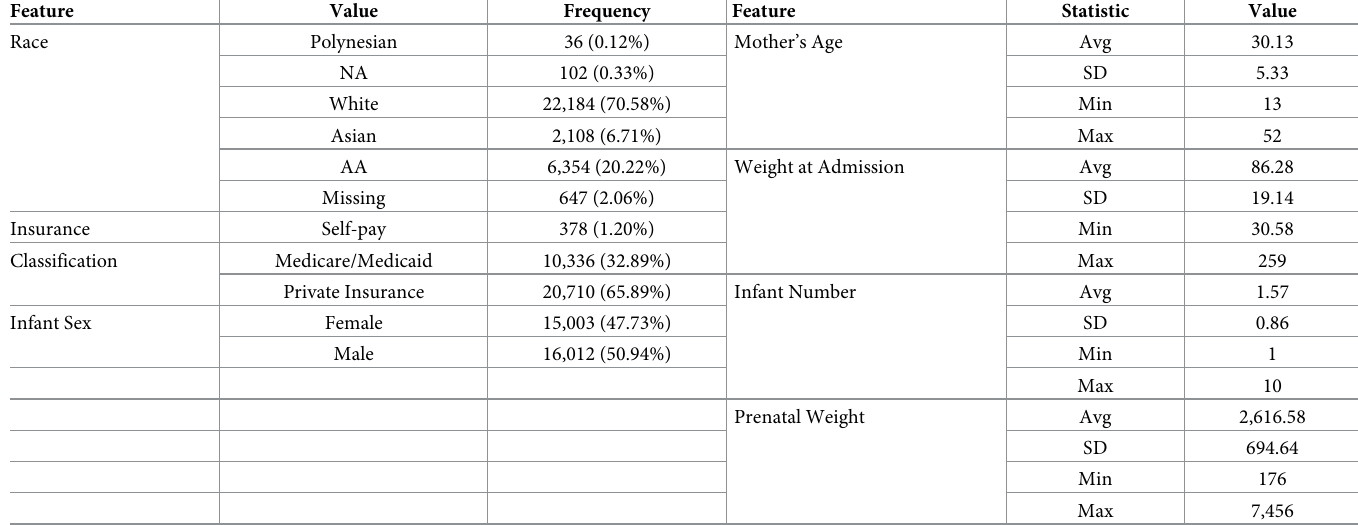
Table 9. Patient demographic attributes in the MOMI data. We report the average (Avg), standard deviation (SD), minimum (Min), and maximum (Max) values for numeric non-discrete attributes.